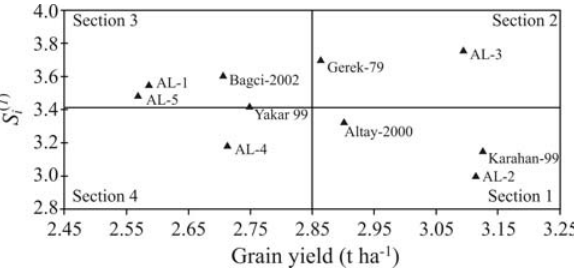
Figure1 -Plotofthemeanabsoluterankdifferenceofagenotypeoveren- vironments ( S i ( 1 ) ) against mean grain yield ( gy , t ha -1 ) for 10 bread wheat genotypes over environments.